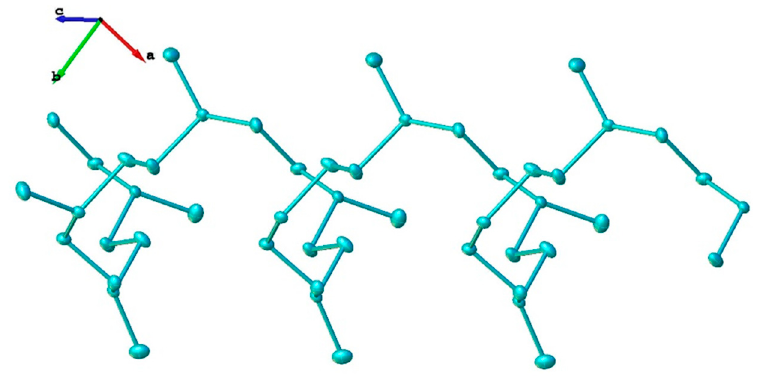
Figure 5. Infinite helix of connected lithium ions in compound Li 5 T 2 B, along the c-axis.